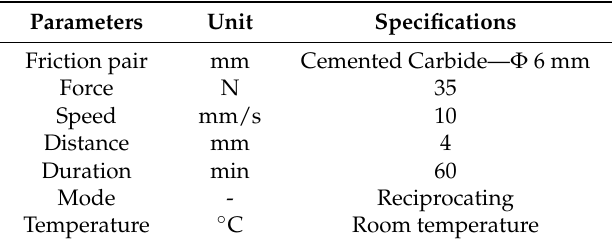
Table 2. Scratch testing parameters.